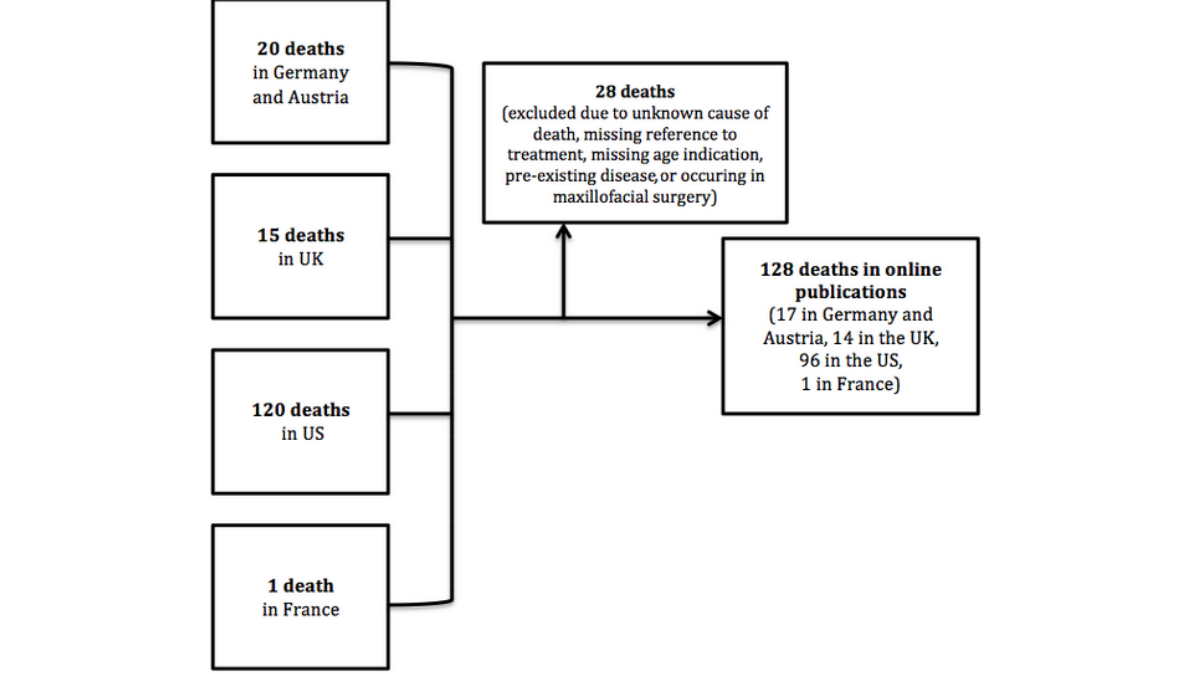
Figure 1. Flowchart for article selection from Google results on the basis of article title. UK: United Kingdom; US: United